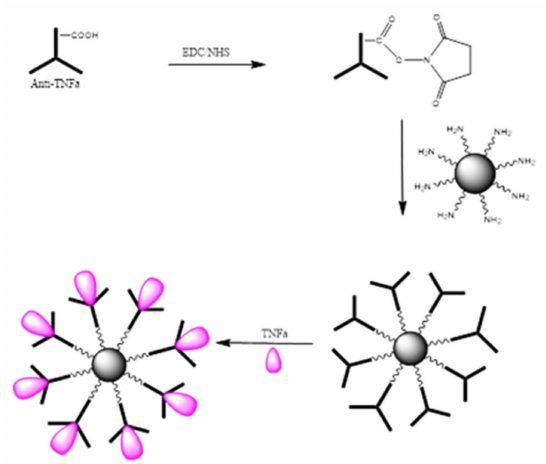
Figure 11. MNP@SiO 2 -NH 2 bio-functionalization with anti-TNF- α antibody.